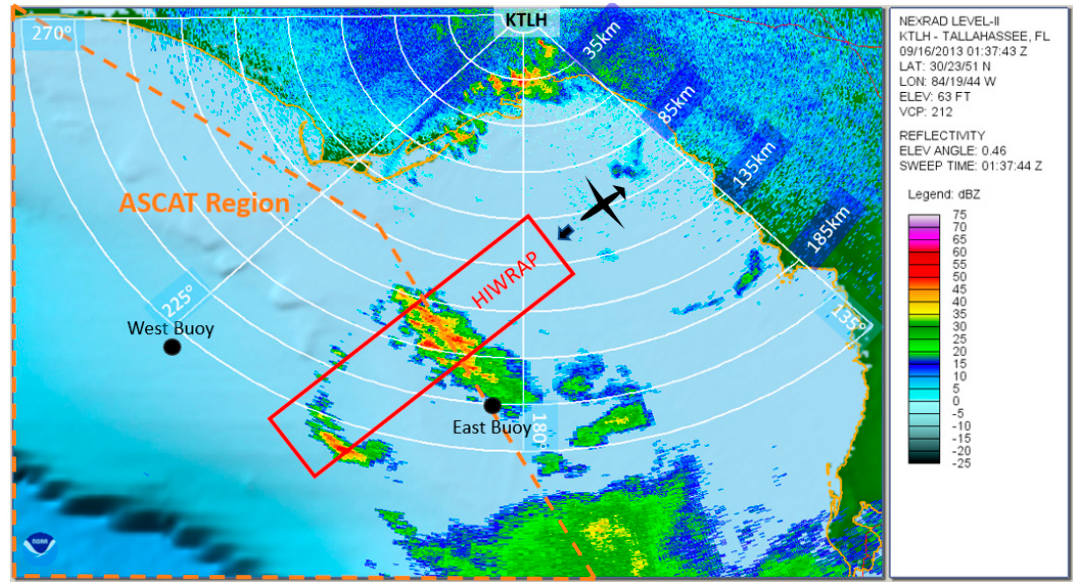
Figure 1. KTLH-NEXRAD radar reflectivity image, color contoured in 5 dBZ steps, on 16 September 2013 at 0137 UTC, where white lines are the range–azimuth grids in 25 km and 45 ° steps. The HIWRAP measurement swath is denoted by the “red box”, the locations of two ocean buoys, East and West (black circles), and the corresponding ASCAT measurements coverage in the orange dashed line boundary. The NEXRAD image was produced using the NOAA Weather Climate Toolkit.